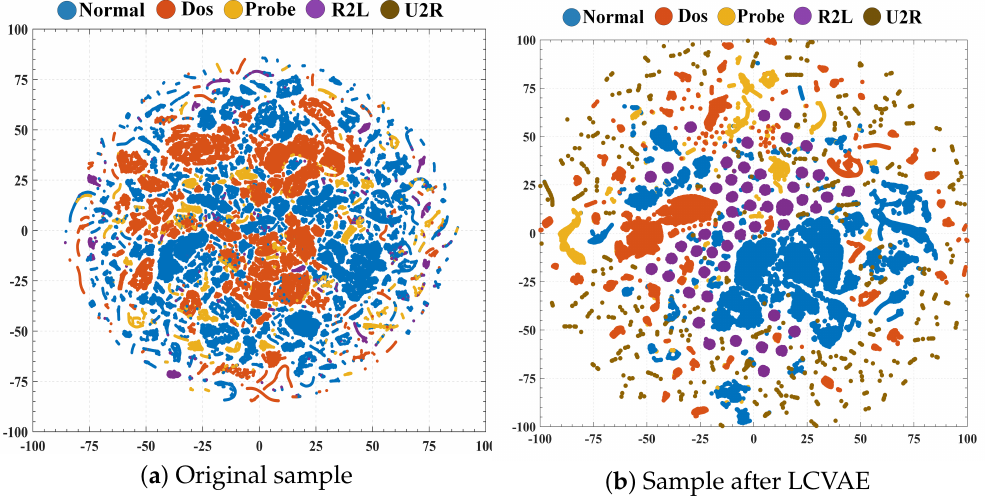
Figure 9. T − SNE visualization of before and after LCVAE encoding results in